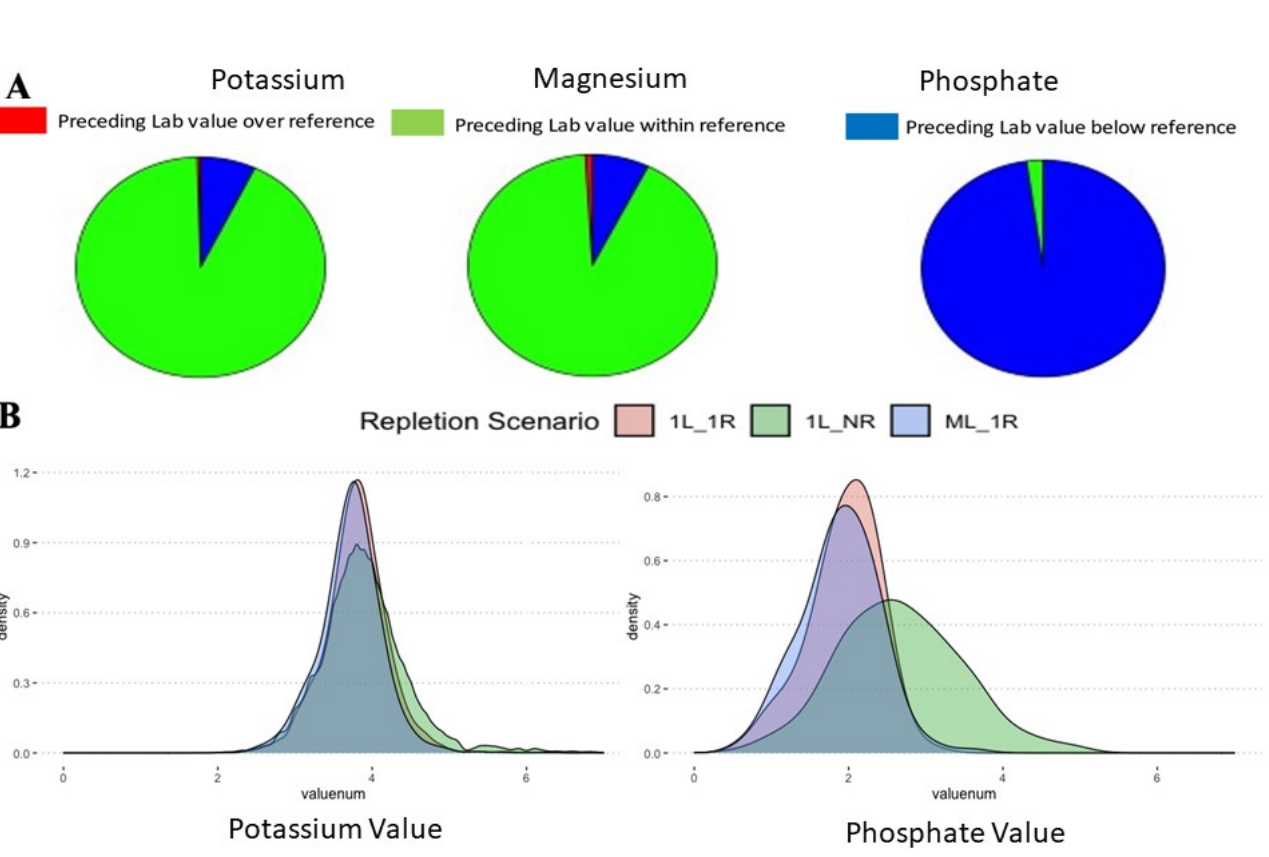
Figure 4. In the case of lab values triggering clinical intervention, most cases for potassium and magnesium have a nominal level of electrolyte but not phosphate ( A ). Concomitantly, the threshold for repletion was very fuzzy and overlapped in the case of potassium and phosphate when repletion did take place (1L_1R) vs cases when repletion did not happen (1L_NR) (B). Table 1. Comparison pre-order lab values for all three major electrolytes during the three clinical scenarios.